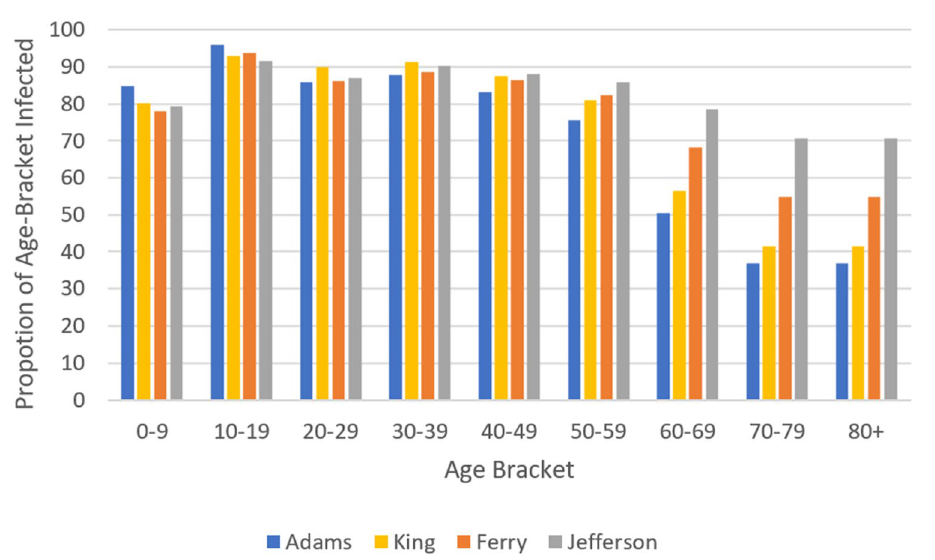
Figure 10. Proportion of age-bracket